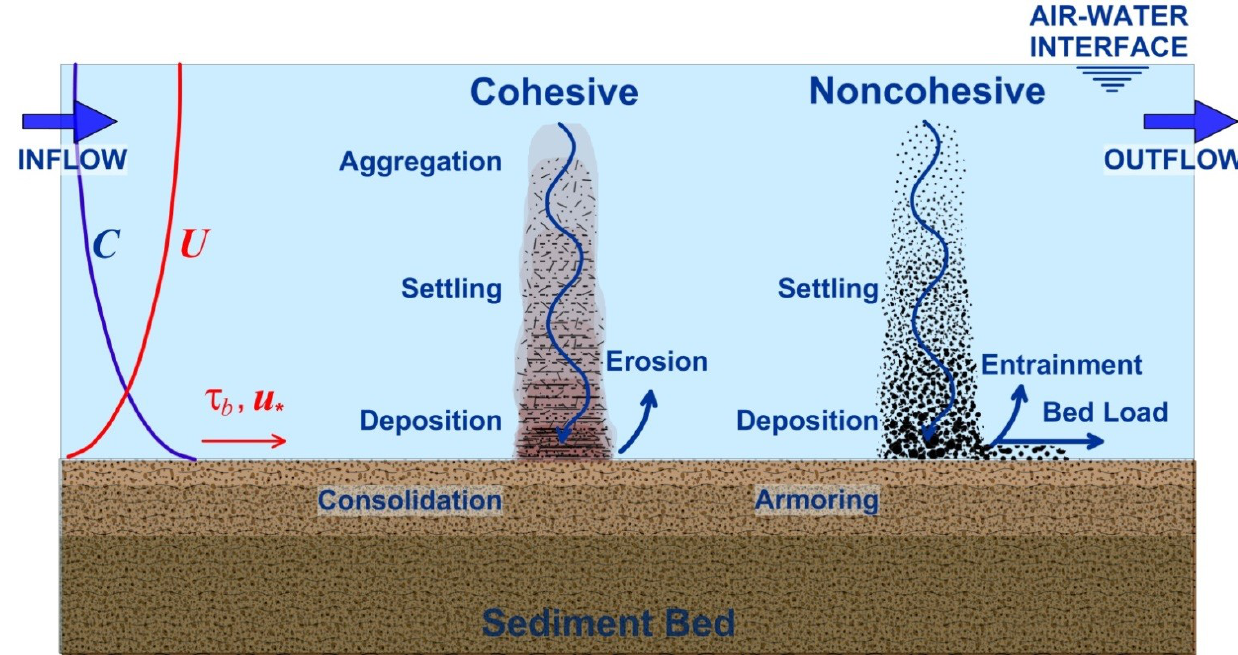
Figure 4. Schematic of sediment transport processes where C is the suspended sediment concentration profile, U is the velocity profile, τ velocity. Concentration and velocity profiles are conceptual only. The concentration profile reflects increased sediment concentration with depth, and the velocity profile decreases to zero at the sediment